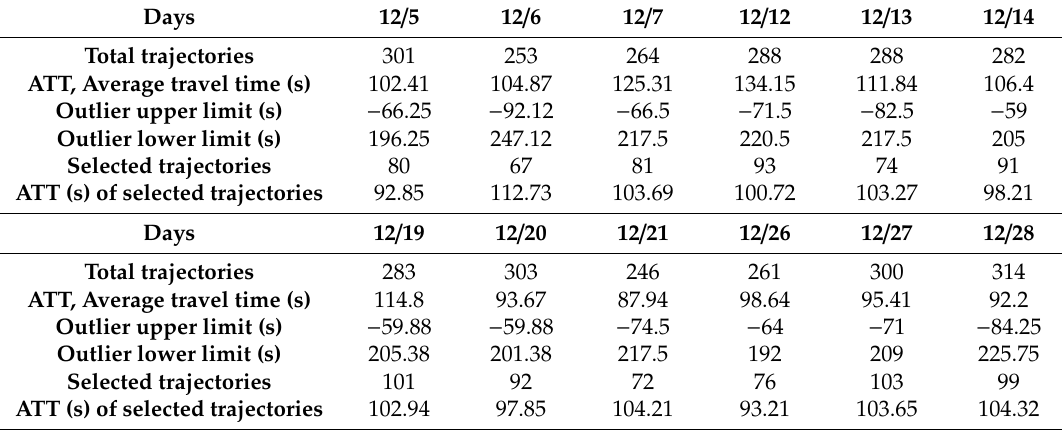
Table 5. Vehicle trajectory selection results.